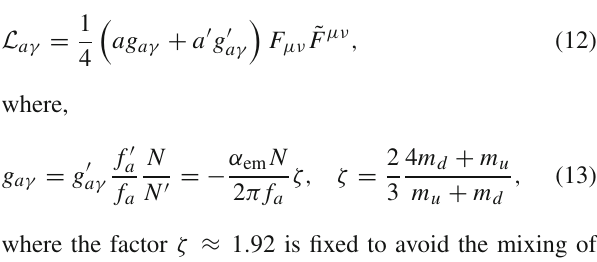
} = { 3 , 1 / 2 , 13 / 2 , 3 / 2 } , 1 and an ficients: { N , N (cid:3) , N g , N (cid:3) g instanton contribution ratio conservatively set to κ = 0 .